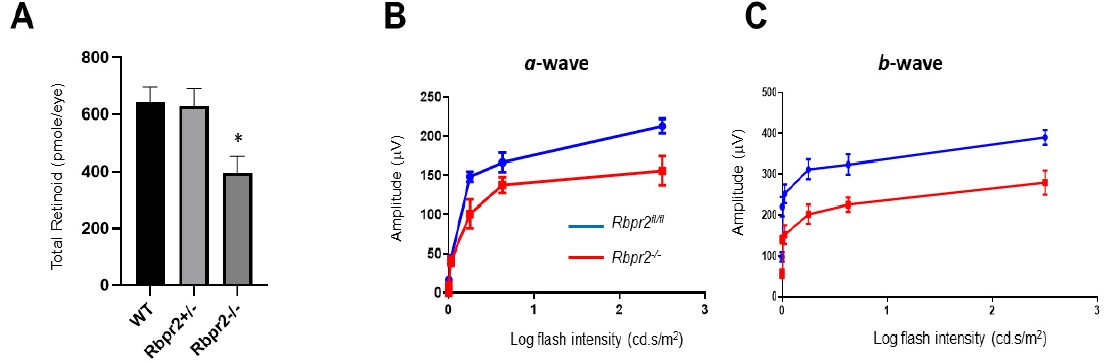
Figure 3. Rbpr2 − / − mice on vitamin A-sufficient diets show decreased ocular retinoid concentra- tion and loss of visual function. ( A , B ) Quantification of total retinoid concentrations (pmole/eye) in eyes from WT, Rbpr2 +/ − , and Rbpr2 − / − mice (pooled eyes from n = 8 mice per genotype). * p < 0.05, Rbpr2 − / − compared to controls. ( C ) Scotopic electroretinograms of 12-week old control ( Rbpr2 fl/fl ) and Rbpr2 − / − mice on vitamin A-sufficient (VAS) diets. * p < 0.05, for both a - and b -wave; Rbpr2 − / − mice vs. controls.